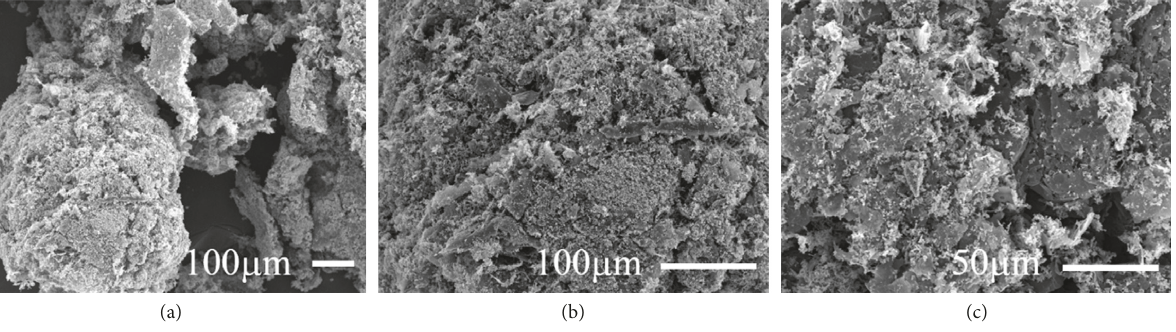
Figure 2: SEM images of EG@MnFe